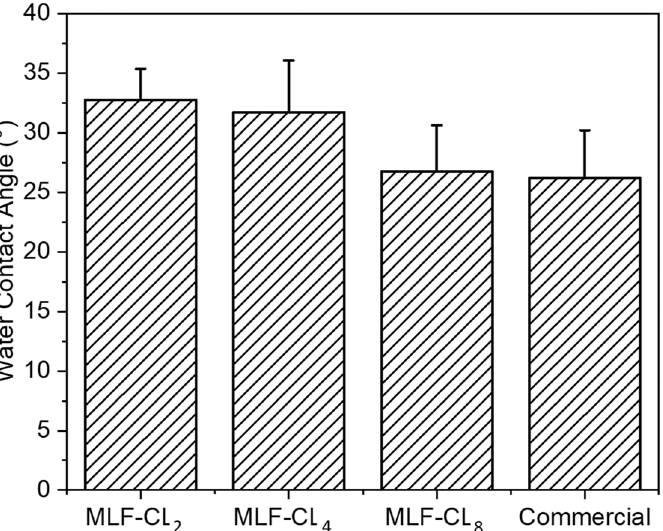
Figure 6. Water contact angle of miltefosine-eluting contact lenses (MLF-CLs) and commercial contact lenses. Quantitative data are expressed as mean ± standard deviation (SD). No significant statistical difference among samples by Kruskal–Wallis Test. p = 0.06, n = 4.